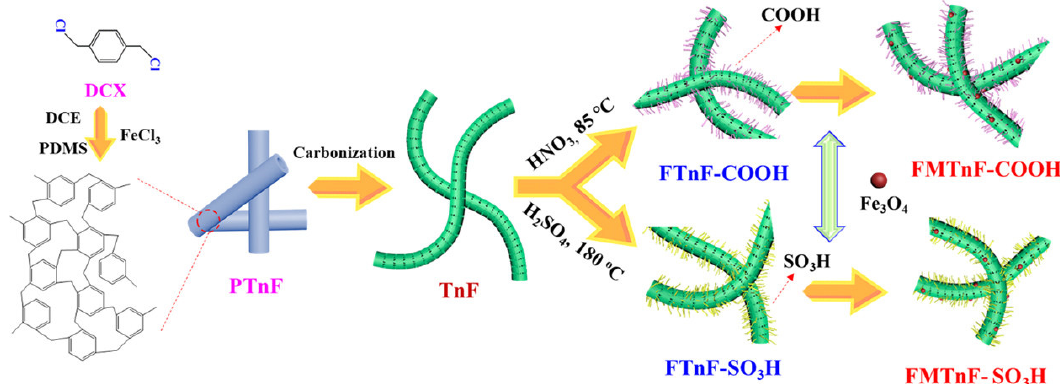
Figure 6. Systematic reaction pathway for the generation of COOH or SO 3 H coated magnetic nanowires. Reprinted with permission from Zhang et al. [118] Copyright 2020 American Chemical Society.